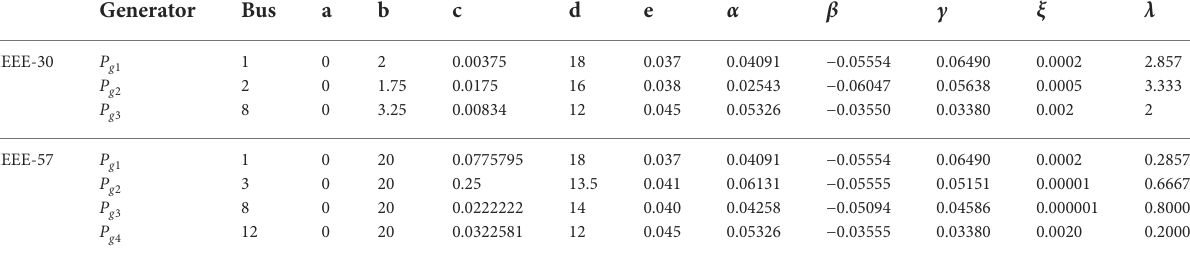
TABLE 2 Costandemissioncoefficientsofthermalgenerators.